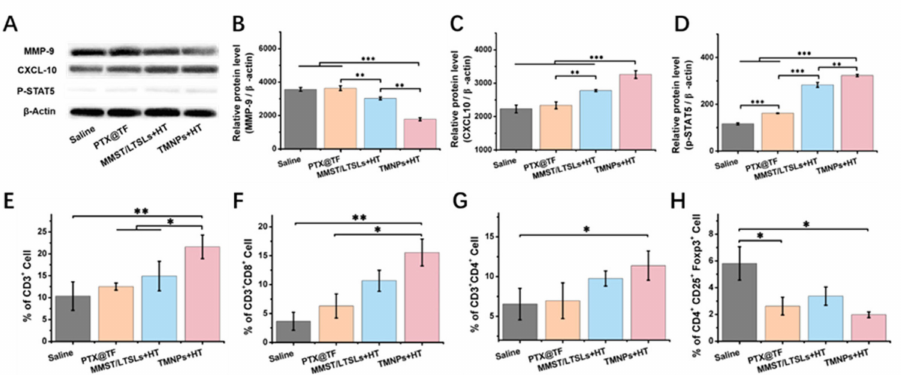
Figure 5. T cell recruiting ability of MMST. 4T1 tumor-bearing mice were euthanized to separate breast tumor at day 29 after saline, PTX@TF, MMST/LTSLs + HT and TMNPs + HT treatment, seven times every three days. ( A ) The expression of MMP-9 and CXCL-10 in tumor tissues and p-STAT5 in lymphocytes of tumor tissues assessed by Western blot. β -Actin was used as a loading control. Dark bands indicate protein expression. Quantitative analysis of the expression of ( B ) MMP-9, ( C ) CXCL10 and ( D ) p-STAT5 by Image pro plus (ChemiScope analysis, mean ± SEM, n = 3, * p < 0.05, ** p < 0.01, *** p < 0.001). ( E ) The proportions of CD3 + T-cells (CD3 + ), ( F ) CD4 + T-cells (CD3 + CD4 + ), ( G ) CD8 + T-cells (CD3 + CD8 + ) and ( H ) Treg cells (CD4 + CD25 + FoxP3 + ) in tumors were determined by flow cytometry (mean ± SEM, n = 3, * p < 0.05, ** p <